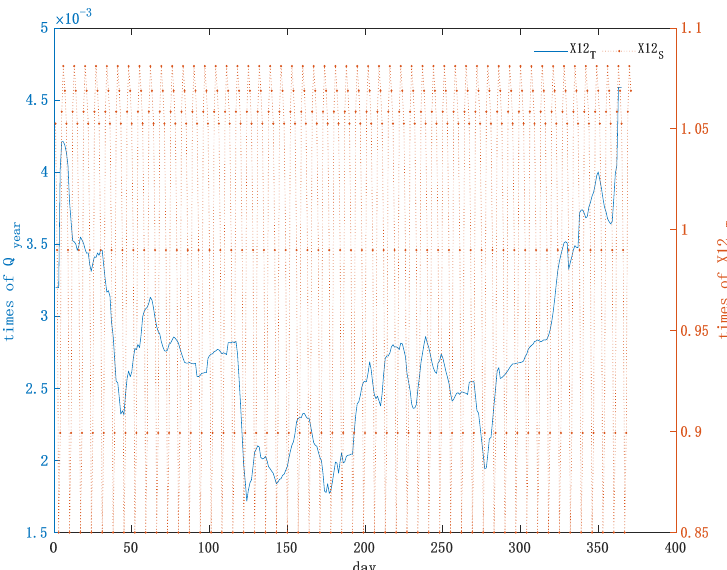
Figure 13. Proportion of trend components and periodic components.